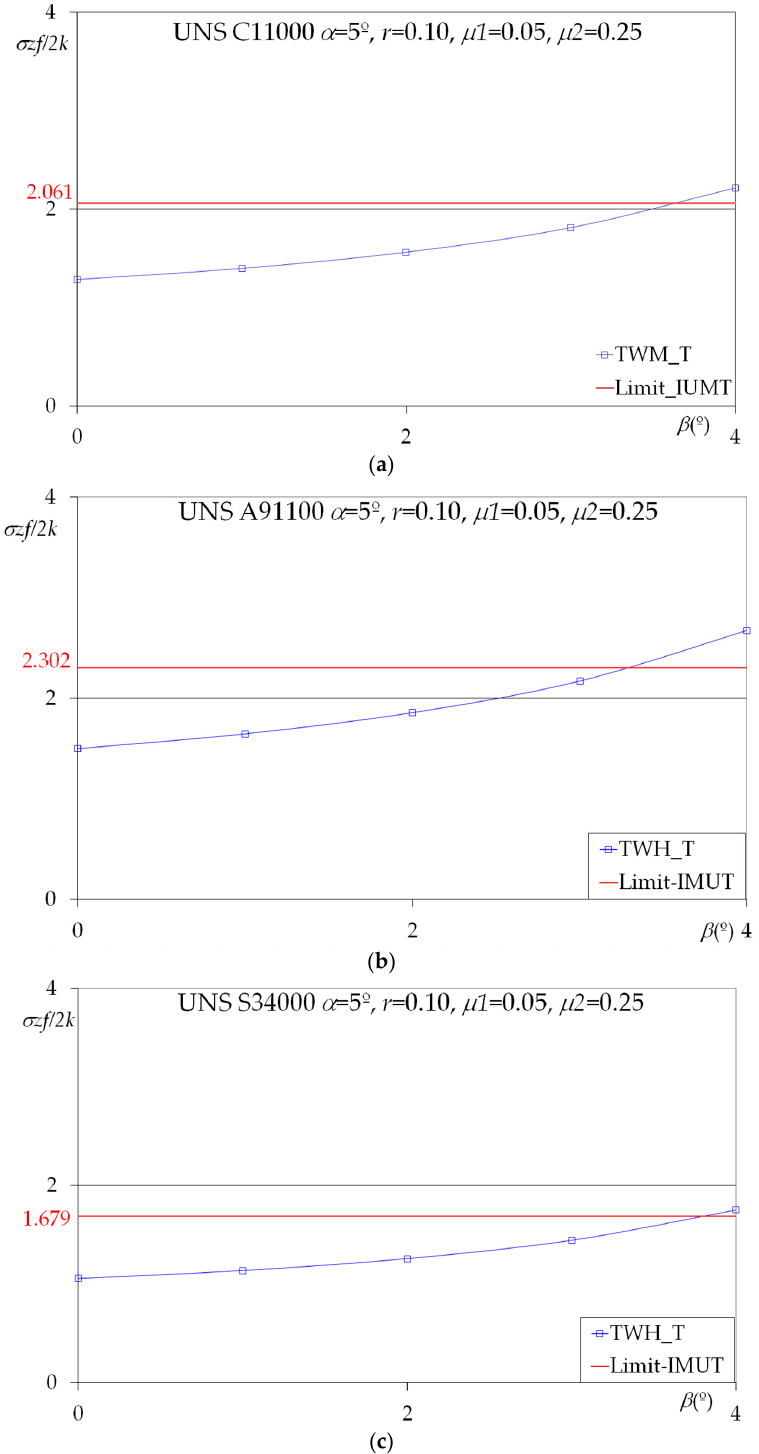
Figure 7. Adimensional total energy calculated for α = 5 ◦ , r = 0.10, µ 1 = 0.05, µ 2 = 0.25, along with the instability limit of the material under tension (Limit-IMUT) for ( a ) copper UNS C11000, ( b ) aluminium UNS A91100, and ( c ) stainless steel UNS S34000.